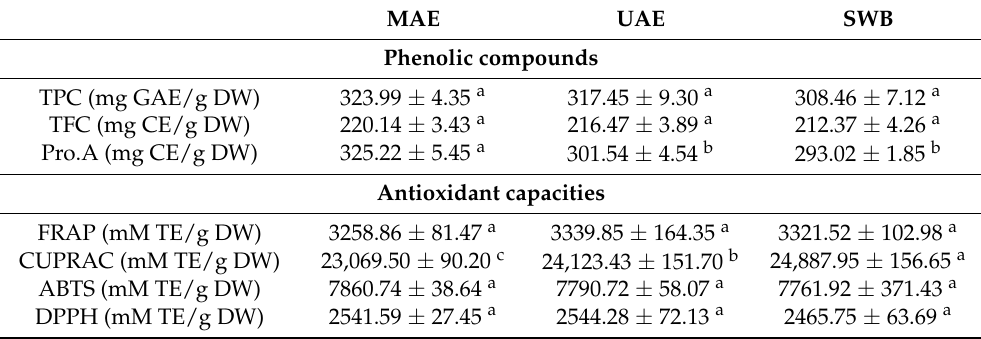
Table 4. Phytochemical and antioxidant content in dried extract from three different extraction